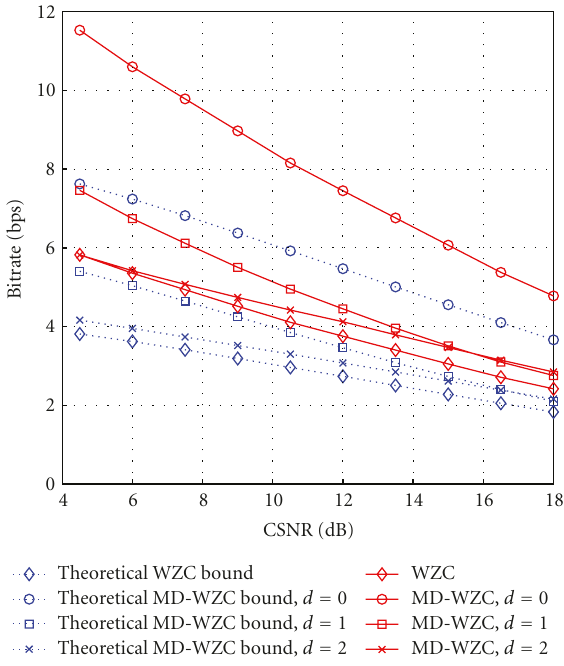
Figure 7: Rate comparison of the WZC and MD-WZC schemes.